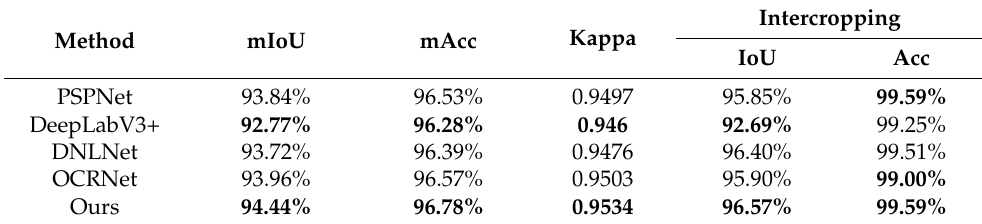
Table 2. Semantic segmentation accuracy results for test area 1.